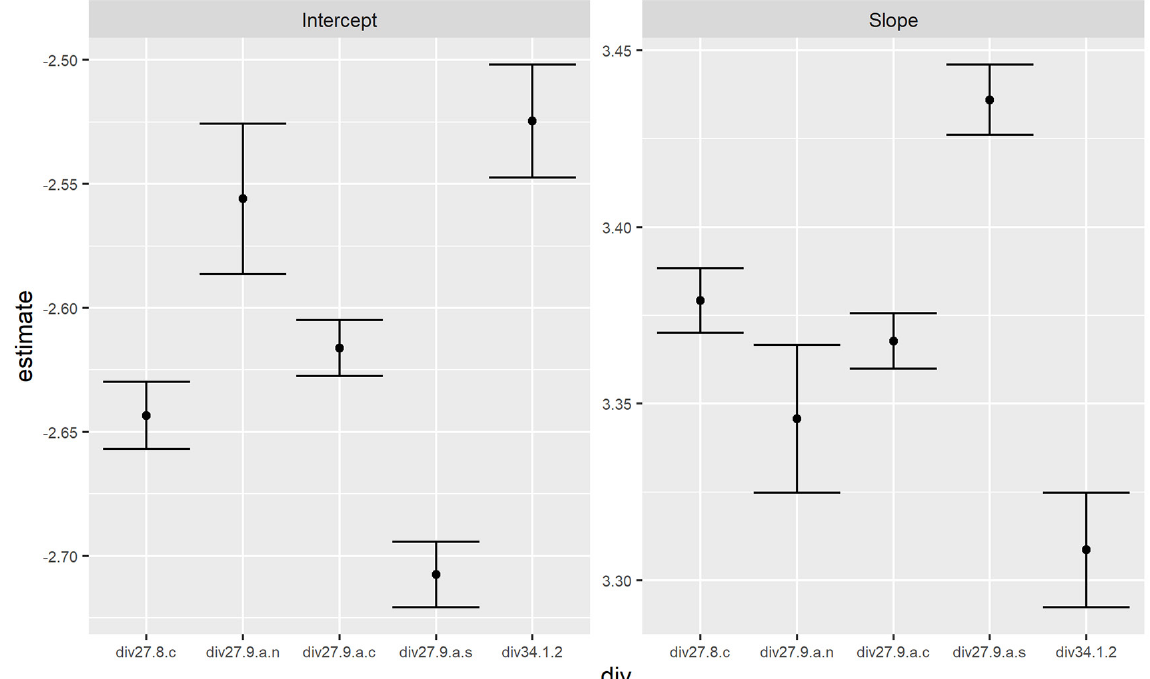
Fig. S4. – Estimations of the intercept and slope of the relationship between total length (cm) and total weight (g) in each study area. Geographical study areas from south to north are 34.1.2, Canary Islands; 27.9.a.s, Gulf of Cadiz; 27.9.a.c, W Portuguese coast; 27.9.a.n, NW Spanish coast; 27.8.c., Cantabrian Sea. Dots represented the mean value; whiskers represented the standard